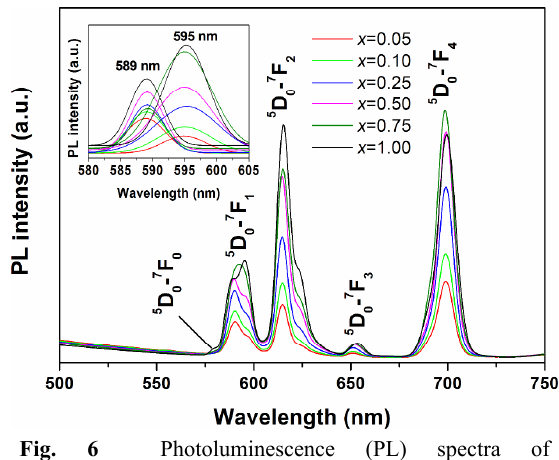
Fig. 6 Photoluminescence (PL) spectra of (Y 1  x Eu x ) 2 (OH) 5 NO 3 · n H 2 O. The PL spectra are measured under intra 4f 6 electronic excitation of Eu 3+ at 395 nm. Inset is the two 5 D 0 → 7 F 1 peaks deconvoluted by Gaussian fitting. Reproduced with permission from Ref. [7], © American Chemical Society 2010.